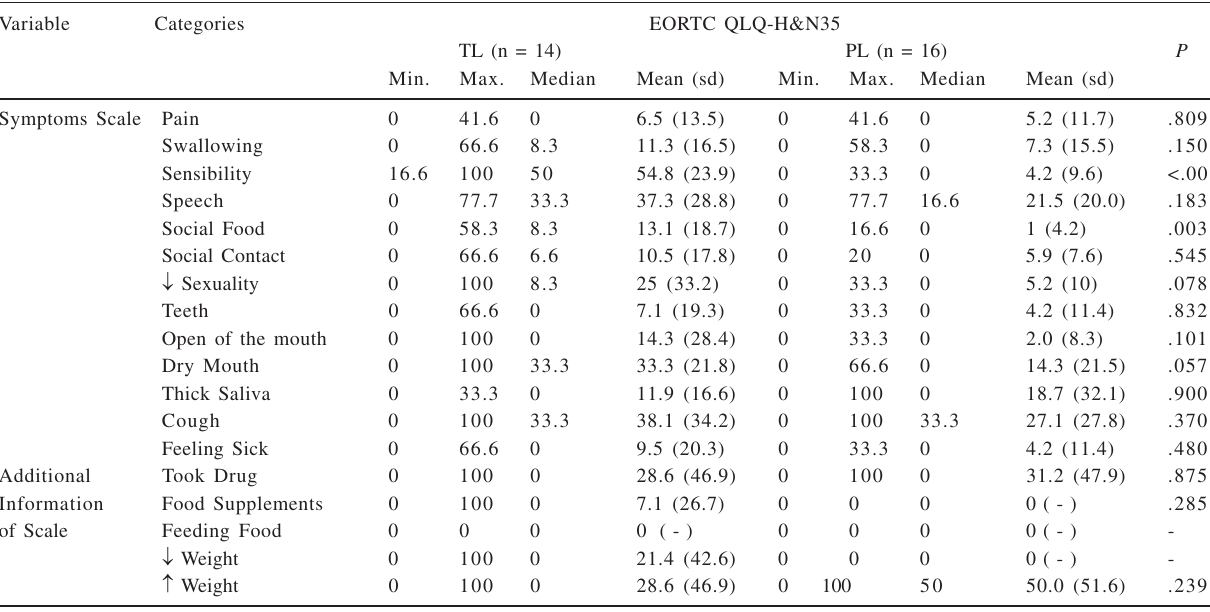
Table 3 - Results of the quality of life of the head and neck specific module EORTC H&N35 – symptom scale and additional information of